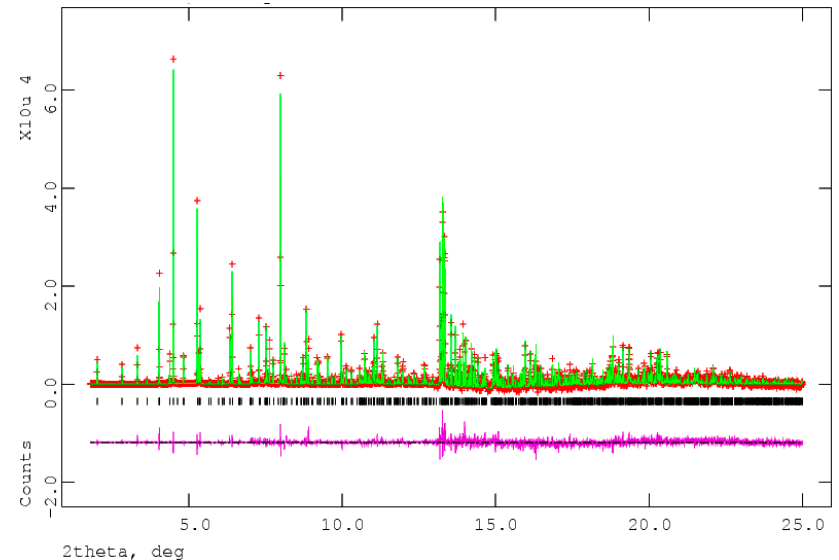
Figure 2. The Rietveld plot for the refinement of 17 α -dihydroequilin, using the incorrect molecular formula C 18 H 20 O 2 . The red crosses represent the observed data points, and the green line is the calculated pattern. The magenta curve is the difference pattern, plotted at the same vertical scale as the other patterns. The vertical scale has been multiplied by a factor of 5 for 2 θ > 7.0°, and by a factor of 40 for 2 θ > 13.0°. X-ray wavelength of 0.413342 Å.